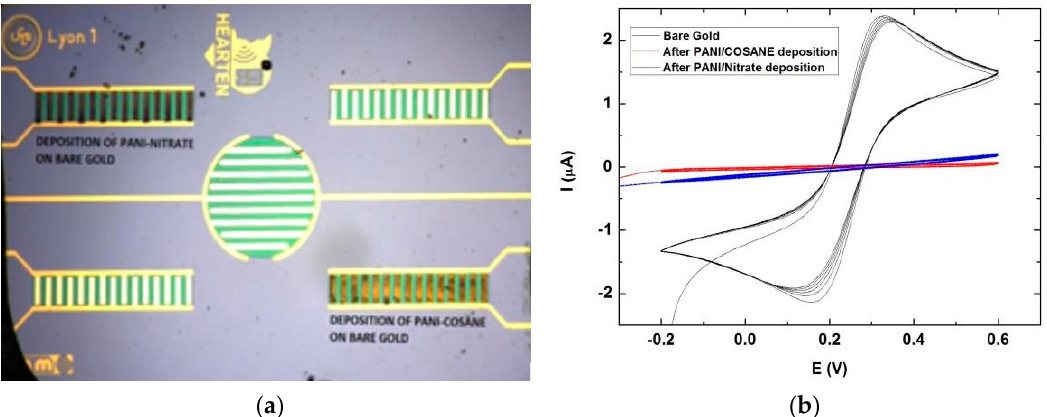
Figure 1. Electrodeposition of PANI/COSANE and PANI/nitrate onto the interdigitated gold microelectrode: ( a ) Interdigitated microelectrode functionalized with PANI-COSANE and PANI- NITRATE; ( b ) Cyclic voltammetry result of bare gold in Fe(II)/Fe(III) cynide solution before and after electrodeposition of sensitive layer onto the Interdigitated micro-electrode.